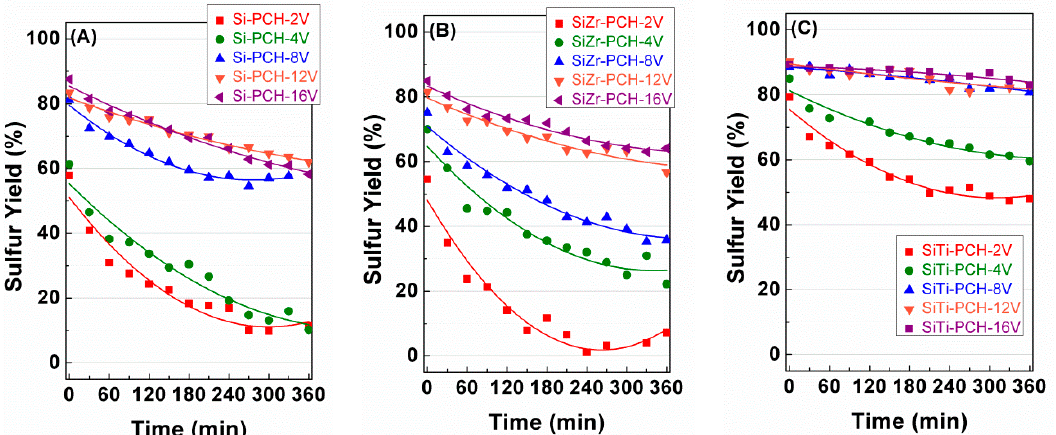
Figure 6. Variation of the sulfur yield with the time on stream (TOS) obtained for V-based catalysts supported on Si-PCH ( A ), SiZr-PCH ( B ) and SiTi-PCH ( C ). Reaction conditions: 0.05 g of catalyst; total